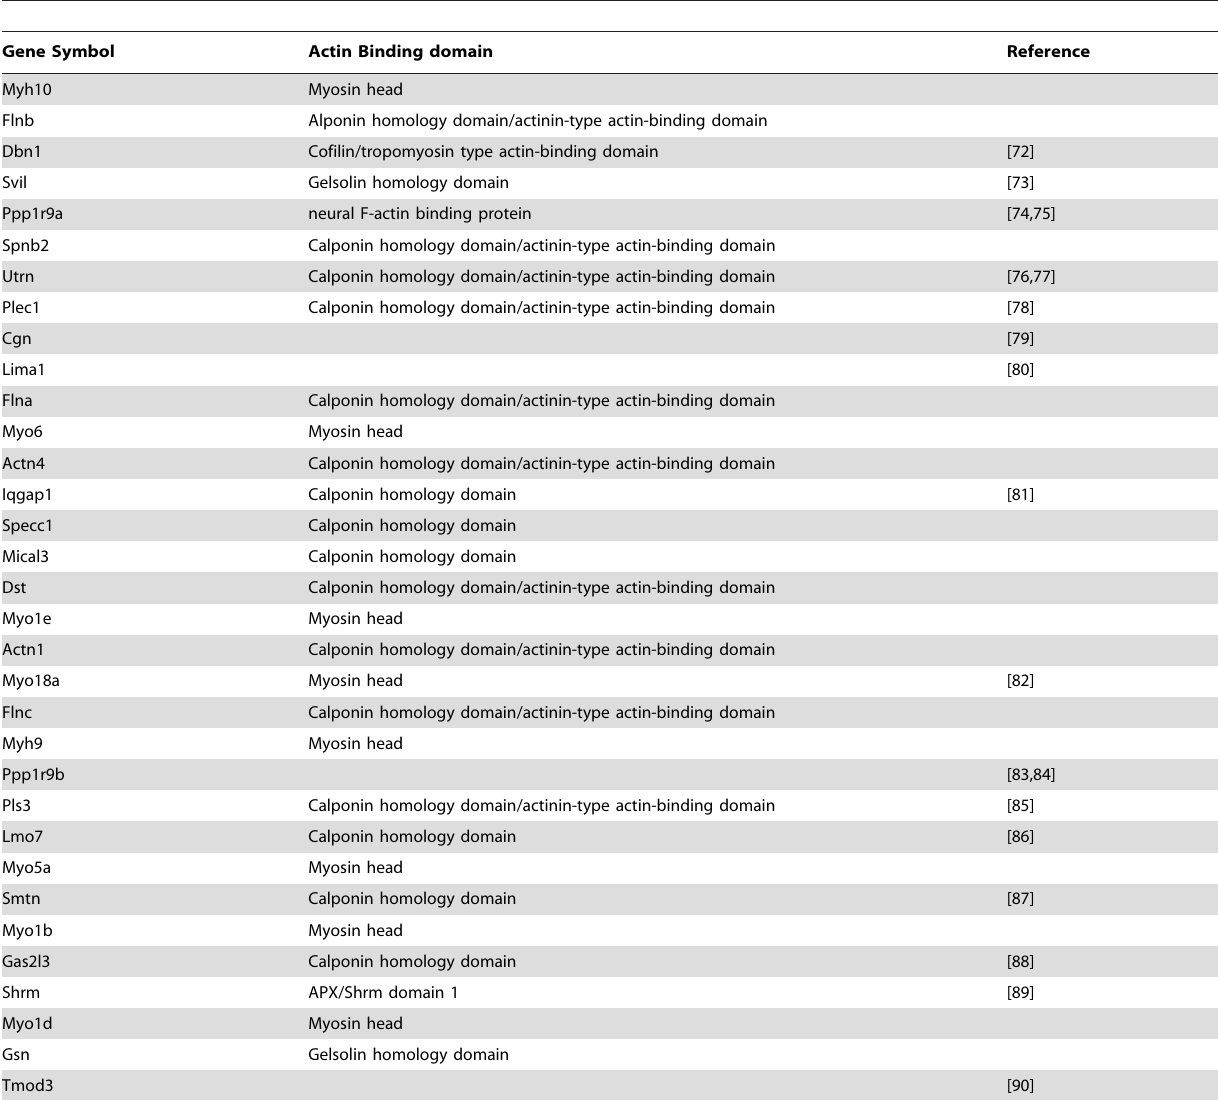
Table 4. Enriched mRNAs that encode proteins with well established and/or have been shown to bind directly to actin.